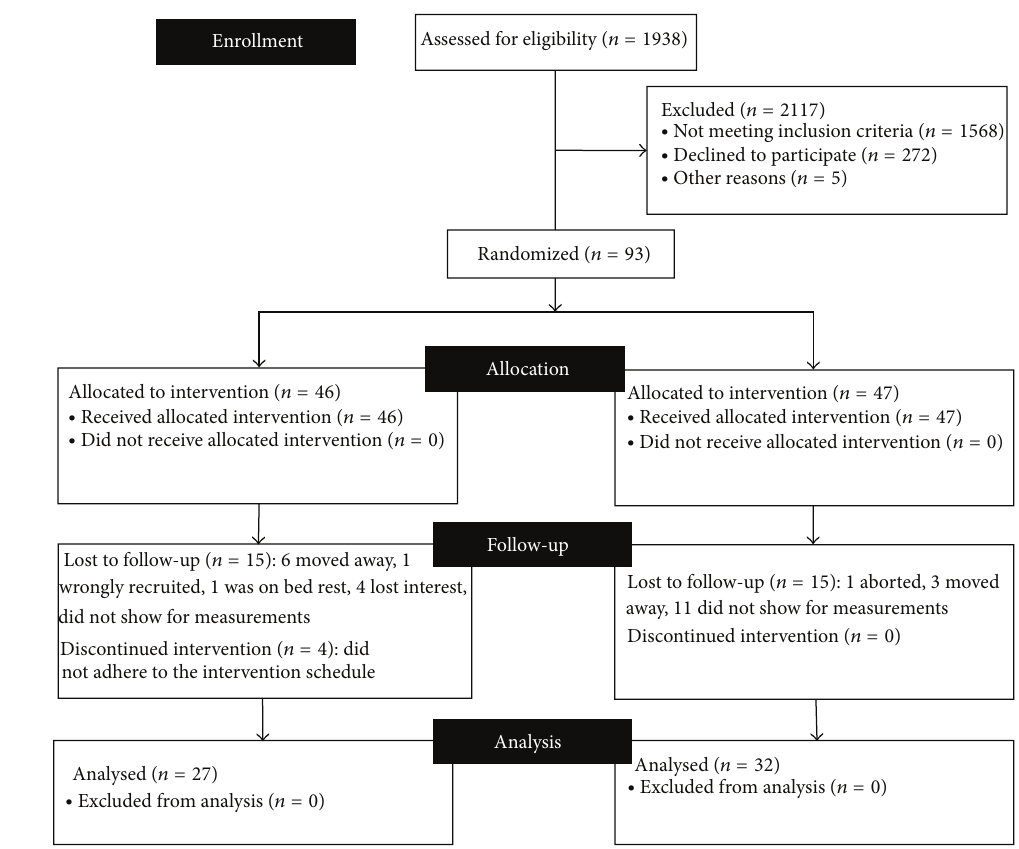
Figure 1: Consort diagram for trial